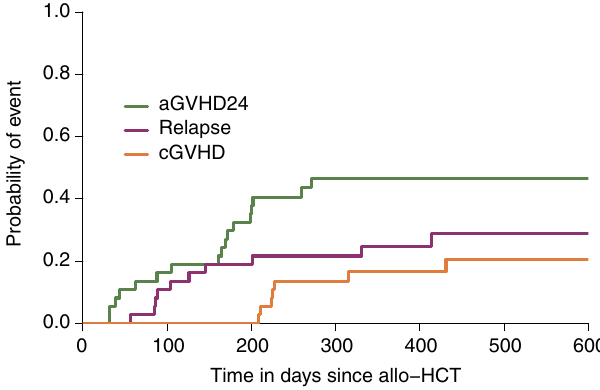
Figure 1. Probabilities of occurrence of each event over time in the studied